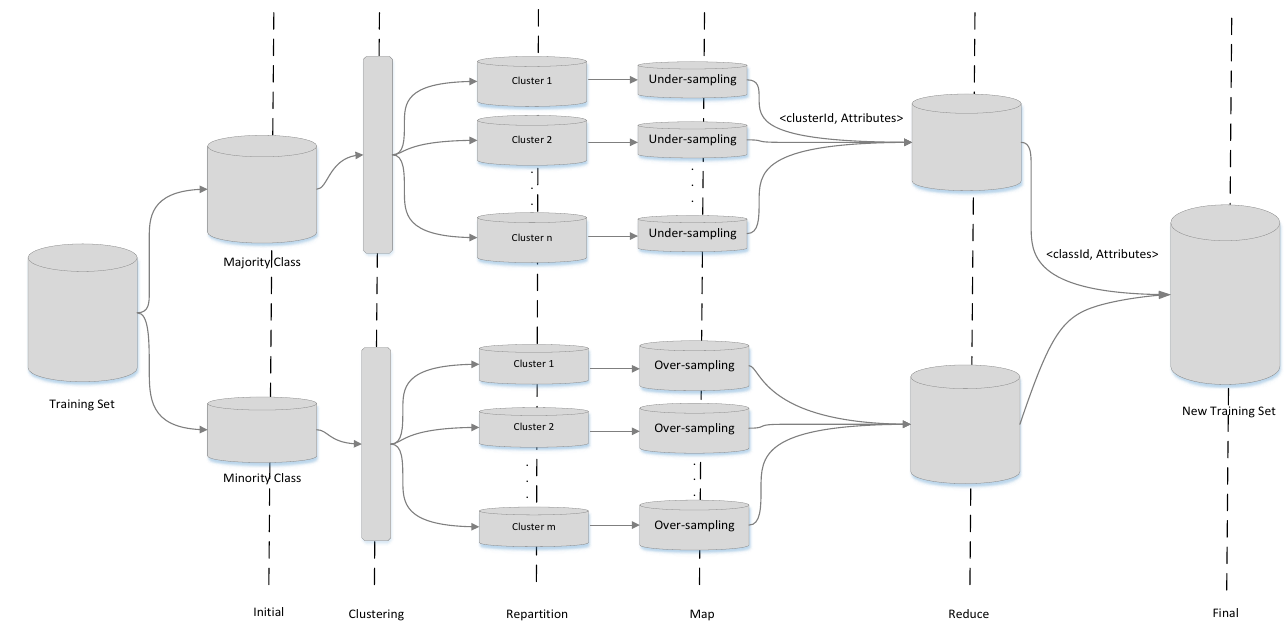
Fig. 2. Flowchart of the MapReduce